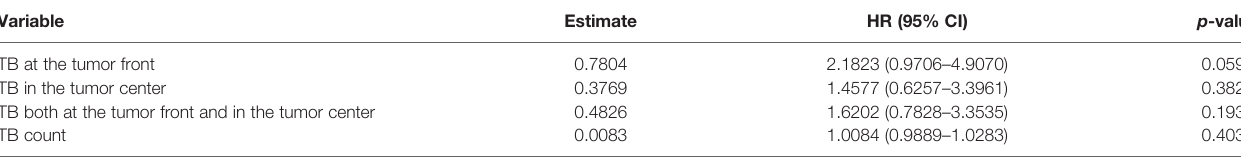
TABLE 2 | Cox regression of tumor budding for pancreatic ductal adenocarcinoma.